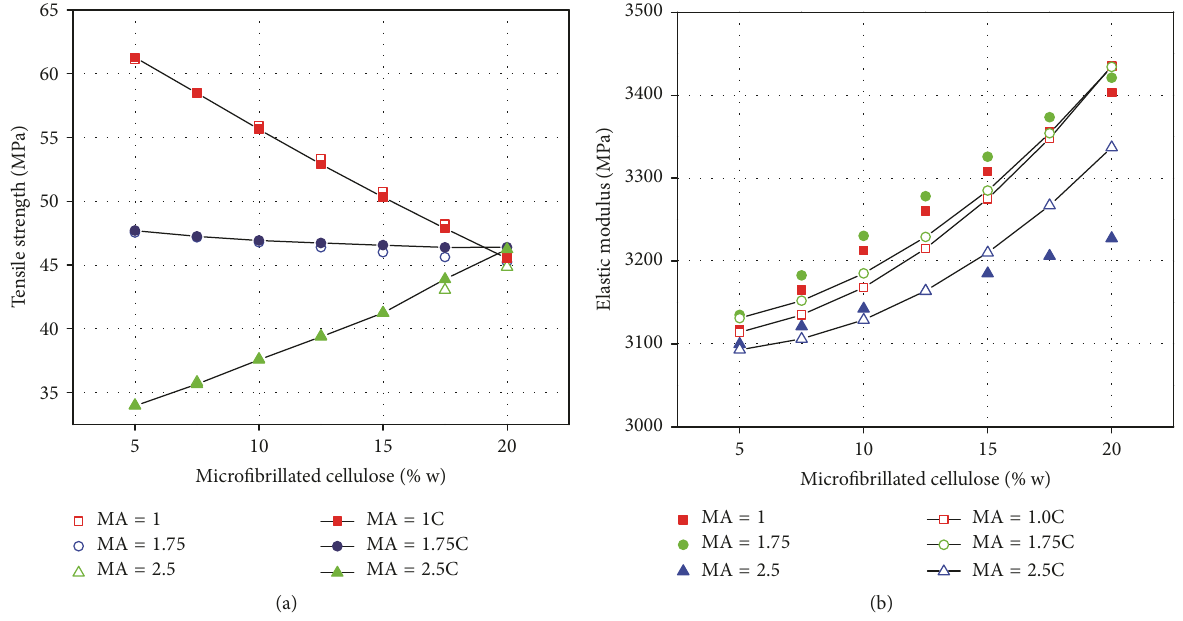
Figure 10: Tensile strength (a) and elastic modulus of biocomposites with different concentrations of PLA-g-MA and HENCEL.